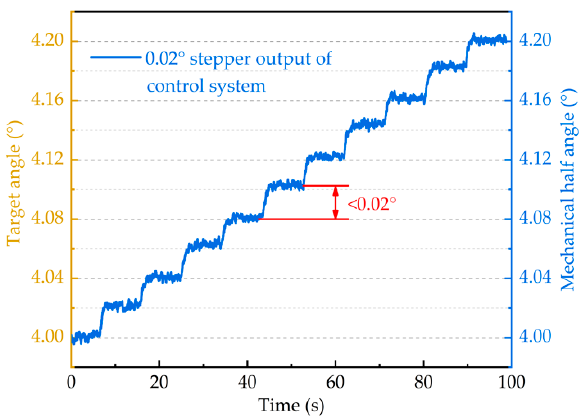
Figure 13. Test result of the compound control system control accuracy. Mechanical half angle of the scanning micrograting is increased by the compound control system with a step of 0.02°.